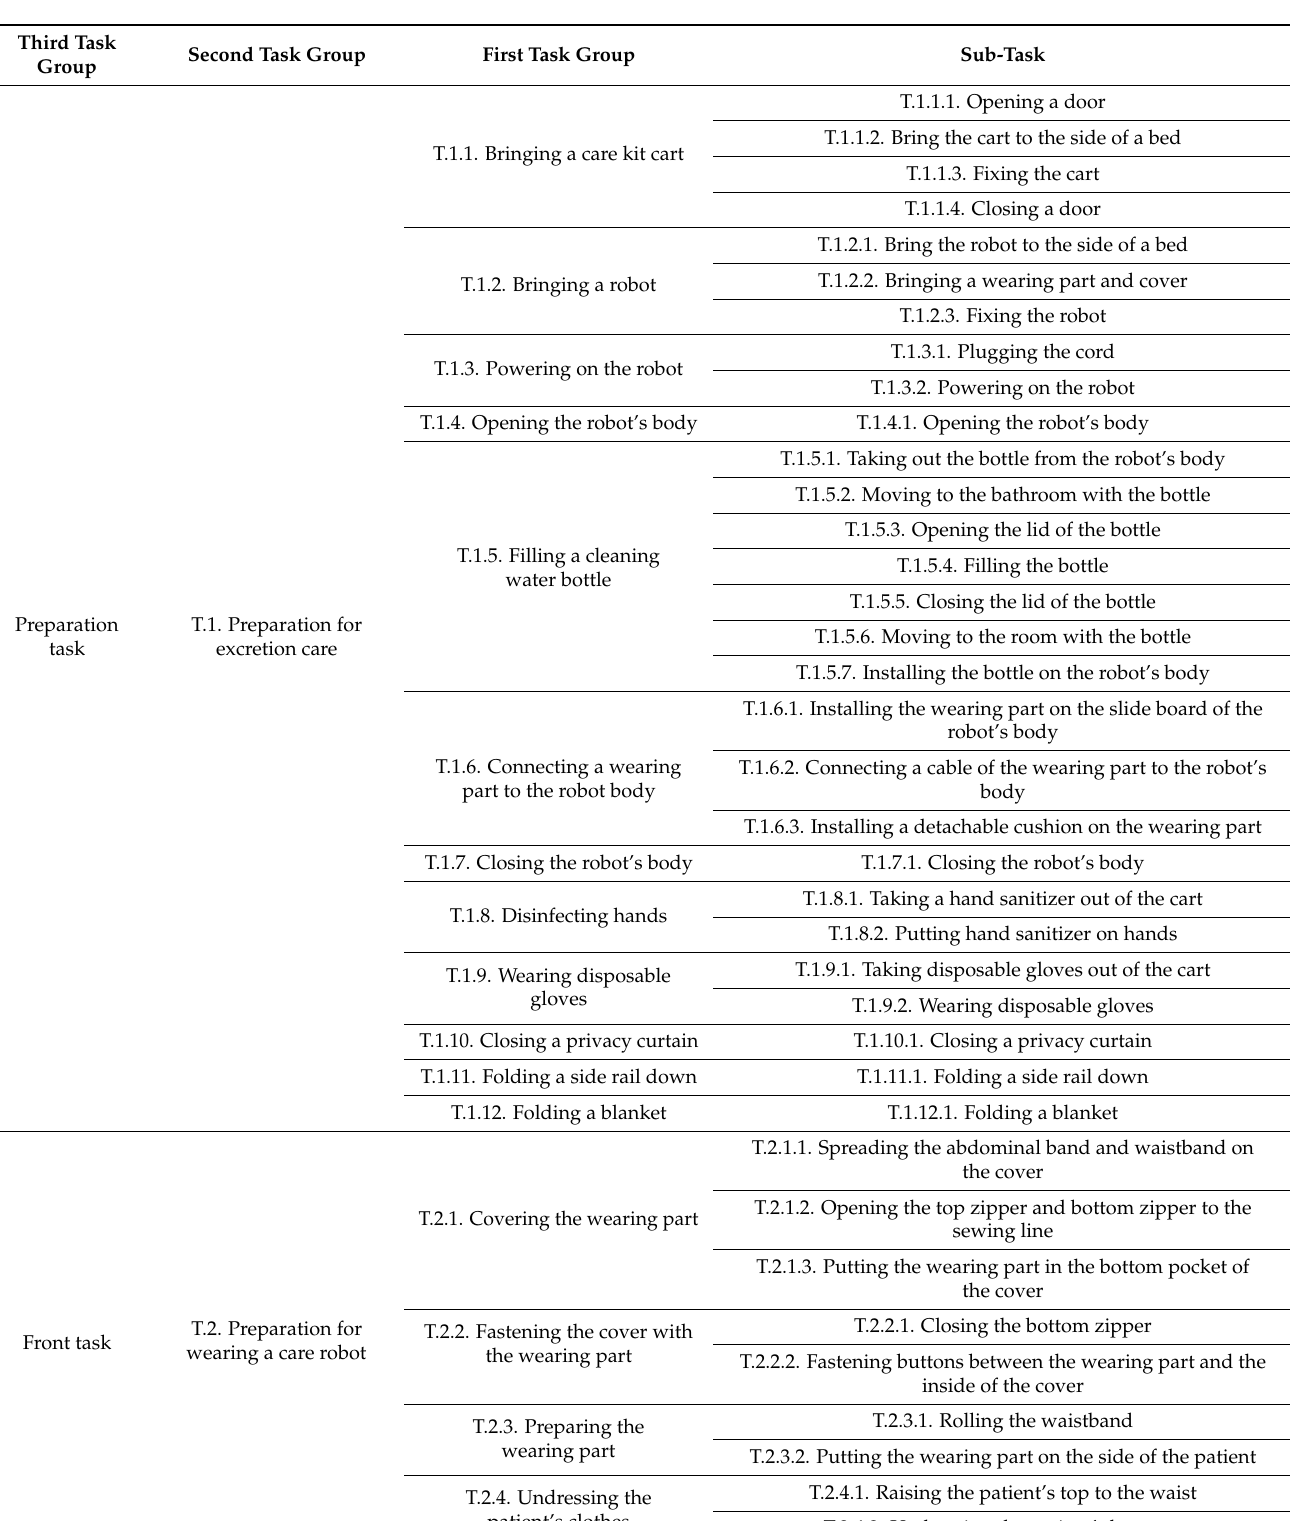
Table A2. The RC